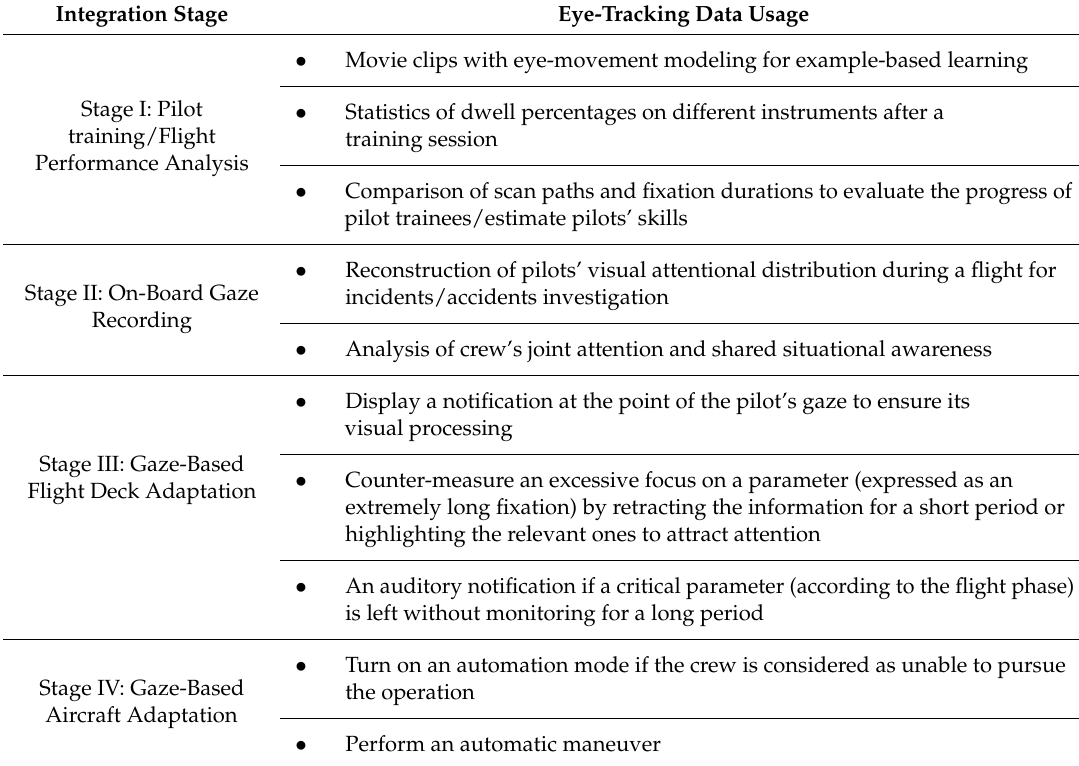
Table 1. Gaze data usage examples within each of the four integration